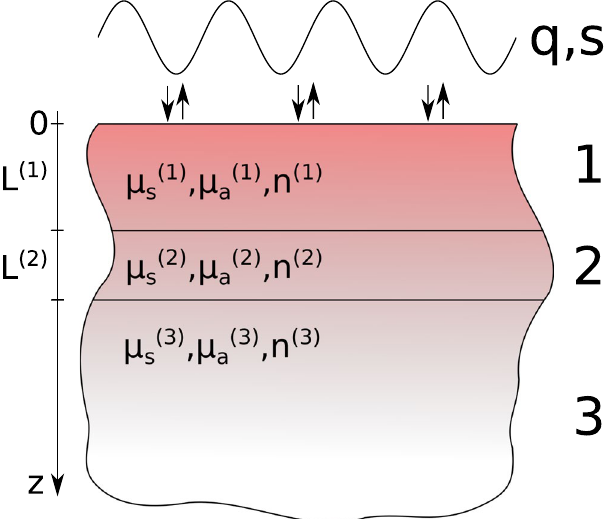
Figure 1. Schematic of the considered three-layered medium. The solution of the RTE is calculated in the Laplace and spatial frequency domains. By numerically inverting these transforms, solutions in the spatial domain and time domain can be obtained. For the fluorescence solution, an additional set of optical parameters for the fluorescence wavelength is assigned to each